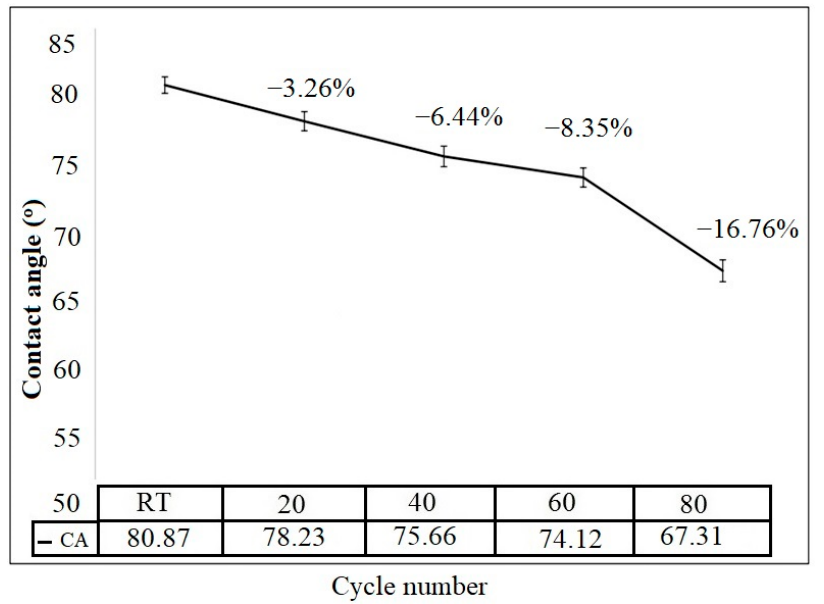
Figure 12. The contact angles and changing of them by increasing cycle numbers in thermal- cycling process.